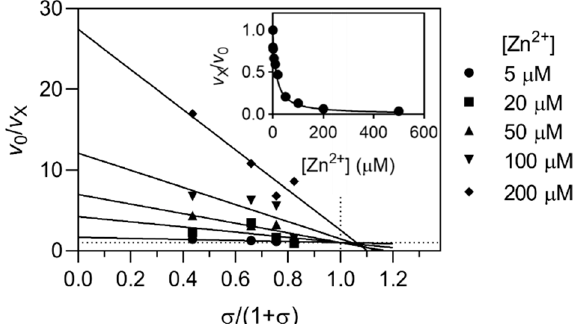
Figure 2. Specific inhibition of cathepsin K by Zn 2+ ions. The mechanism was determined by the specific velocity plot using the fluorogenic substrate Z-Phe-Arg-AMC. σ is equal to [S]/ K m . An additional titration curve recorded with 5 µM substrate ( σ = 1) is shown in the inset. Experiments were performed at 25 °C in 0.1 M sodium acetate buffer pH 5.5.